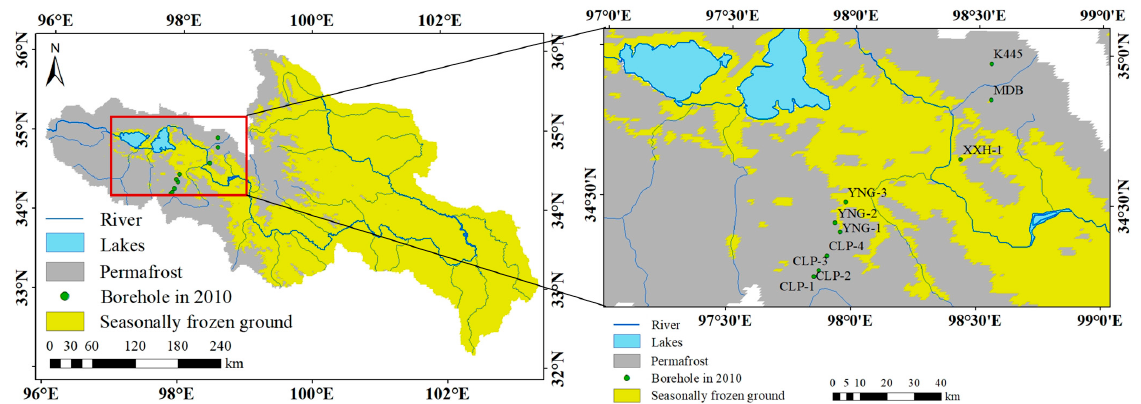
Figure 2. Distribution of the frozen soil estimated by remote sensing in the period from 2005 to 2014, and the locations of the 10 boreholes [32].